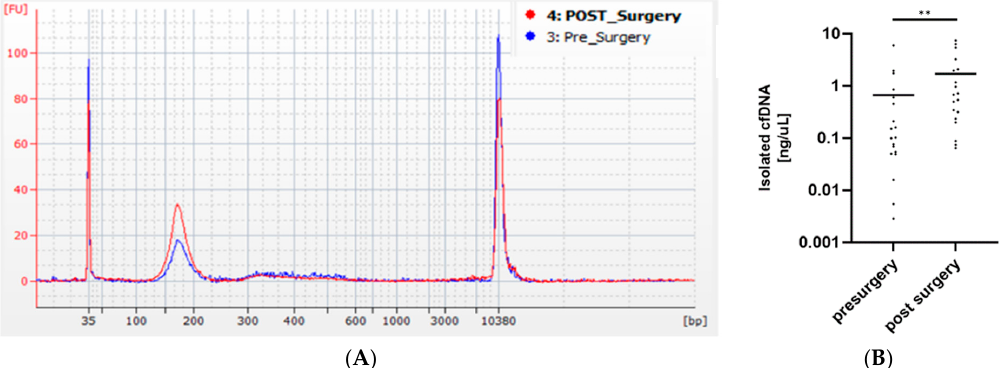
Figure 3. Comparison of yield of ccfDNA isolated from blood samples collected from the same patient before and after surgery. ( A ) Bioanalyzer electropherogram showing increased concentration in a sample of ccfDNA isolated from postsurgery (red) versus presurgery (blue); ( B ) comparison of total isolation yield shows significant increase in ccfDNA amounts isolated from postsurgical versus presurgery blood sample. Statistical significance was calculated using a paired t -test (** p < 0.01), N = 19.